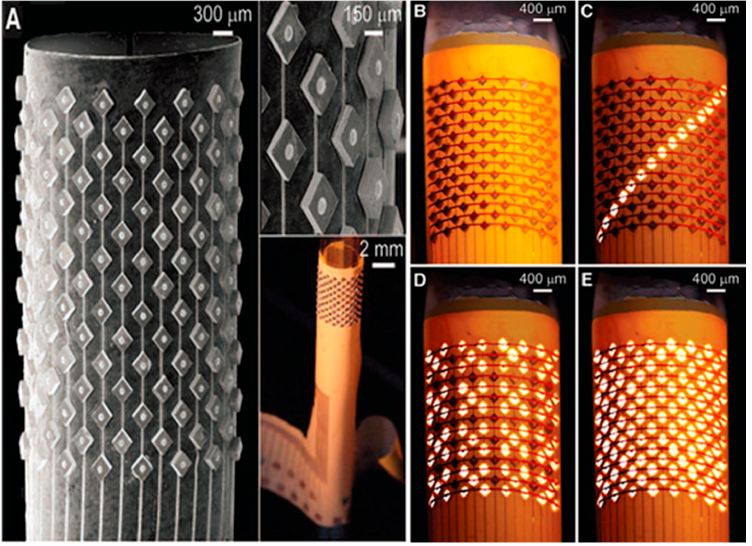
Figure 1. Micrographs of cylindrical display assembled in two self-driven assembly steps: Patterned self-assembly of LEDs onto a bottom electrode and self-alignment of a top electrode. ( A ) SEM and optical images of LEDs that assembled into a regular array. ( B ) Photograph of the display after self-alignment of the top electrode. ( C – E ) Photographs of the operating display segment. Reprinted with permission from [32].